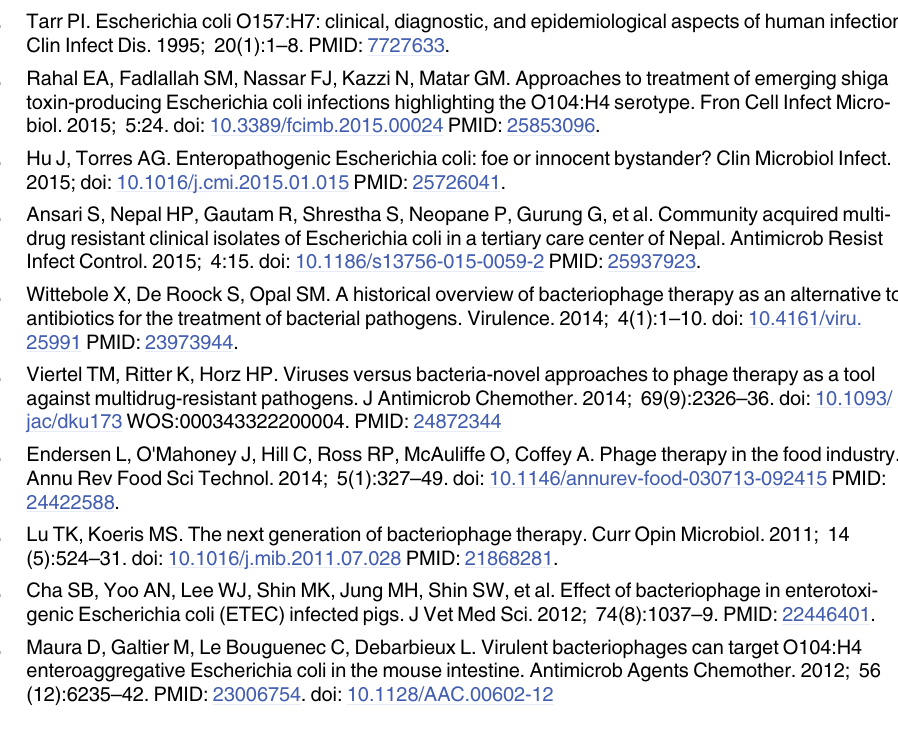
S1 Table. Ten first BLASTP hits of φ APCEc01 ORFs. S2 Table. Ten first BLASTP hits of φ APCEc02 ORFs. S3 Table. Ten first BLASTP hits of φ APCEc03